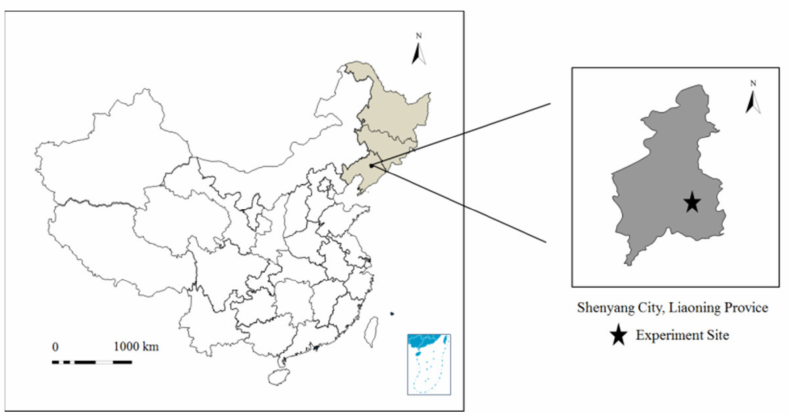
Figure 6. The geographic location of the study site.